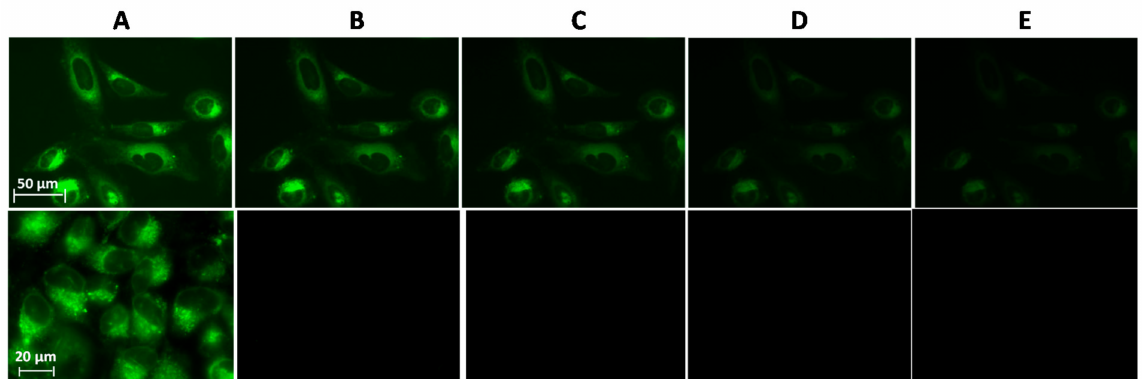
Figure 3. Images obtained from photobleaching experiments. HeLa cells incubated (top) during 1 h and 30 min with a 30 µ M solution of the 3a or (bottom) during 30 min with a 50 nM LysoTracker Green DND-26 after exposure to a continuous excitation light selected with a 485 nm (band pass 20 nm filter) collected at different times: ( A ) 0 s, ( B ) 25 s, ( C ) 45 s, ( D ) 100 s,